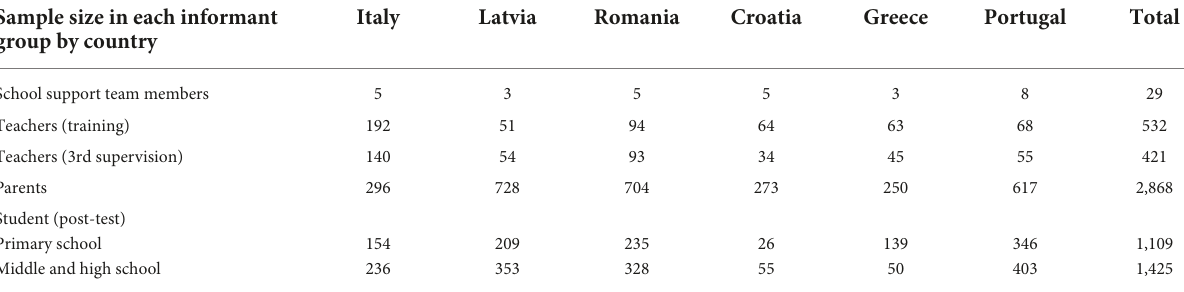
TABLE 1 Sample sizes for monitoring the implementation of Promoting Mental Health at Schools (PROMEHS). Sample size in each informant group by